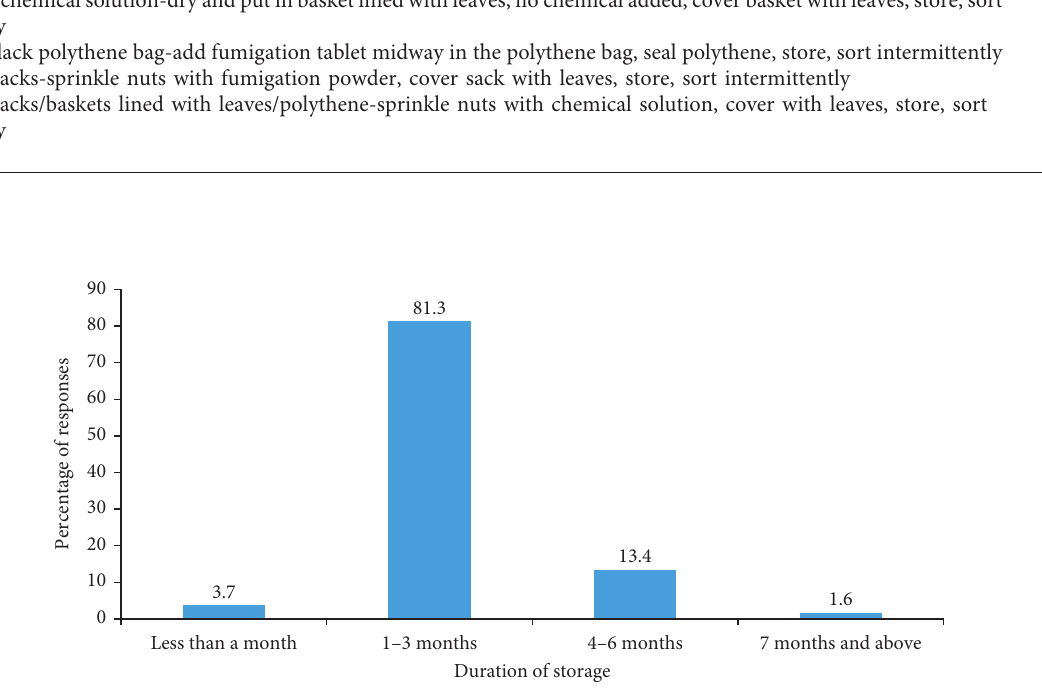
Figure 12: Duration of storage for cured